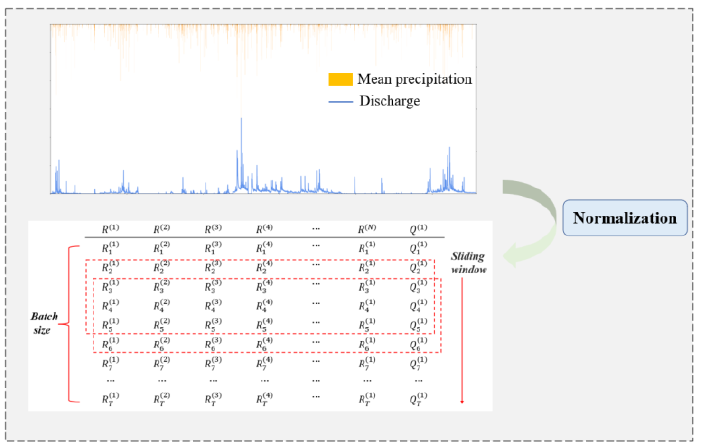
Figure 6. Process of dataset preparation.